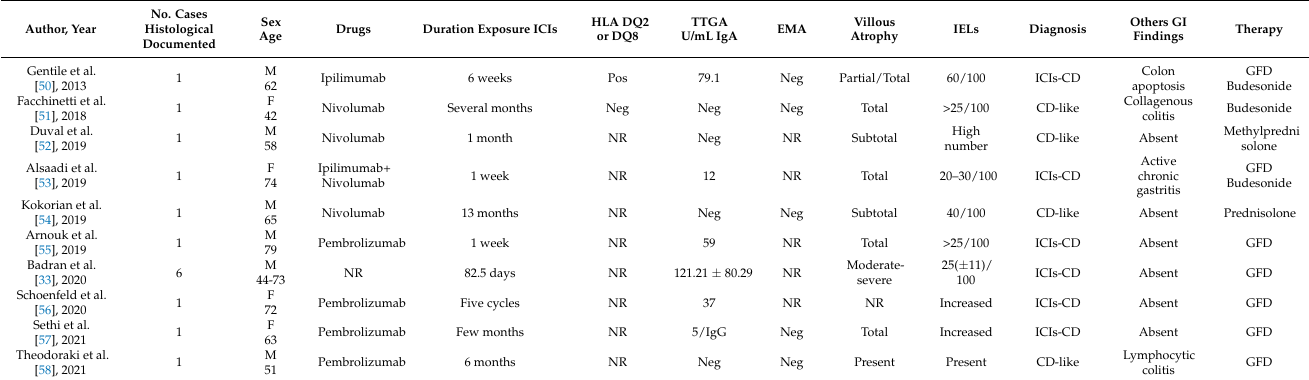
Table 1. Studies reporting cases of celiac disease and celiac like conditions related to ICIs